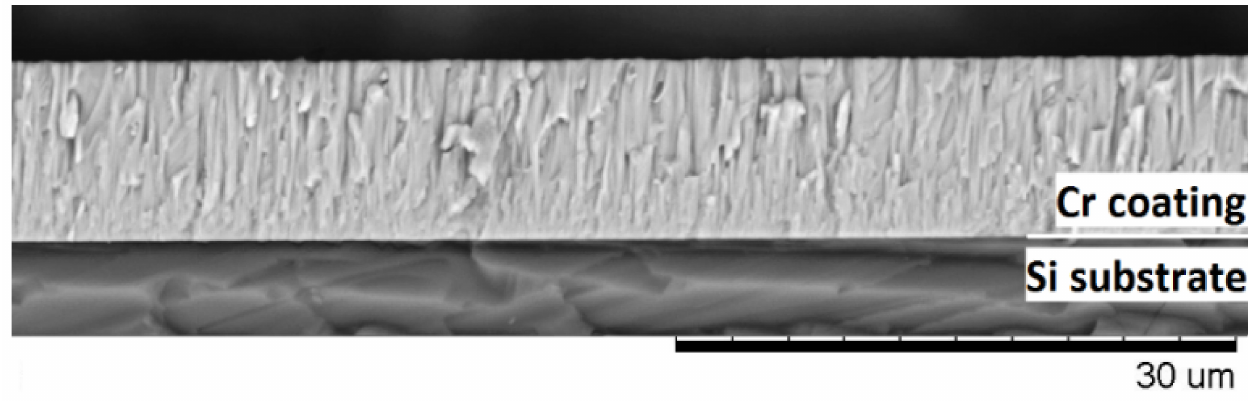
Figure 2. The cross-section of the as-deposited Cr coating on Si substrate.